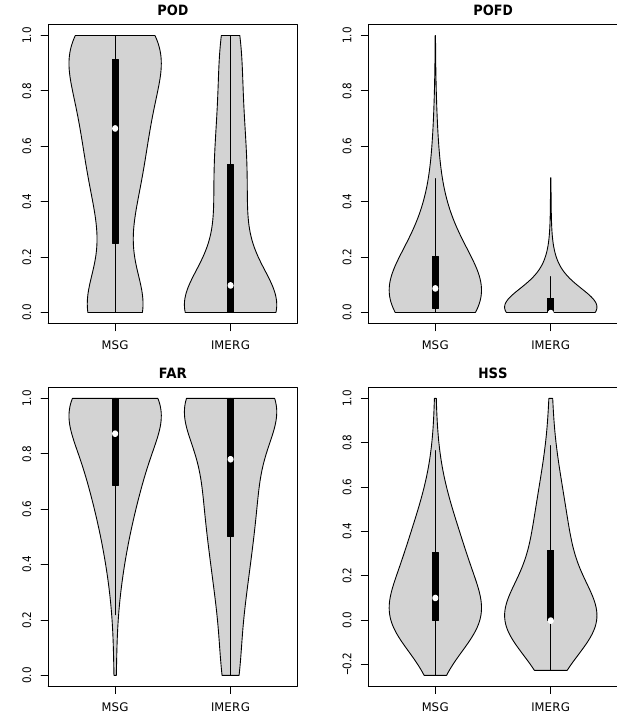
Figure 8. Comparison of the performance of the MSG-based re- trieval and GPM IMERG for rainfall area delineation between March and August 2014. Each of the data points is the average per- formance of 1h. See Fig. 3 for further information on the figure style.